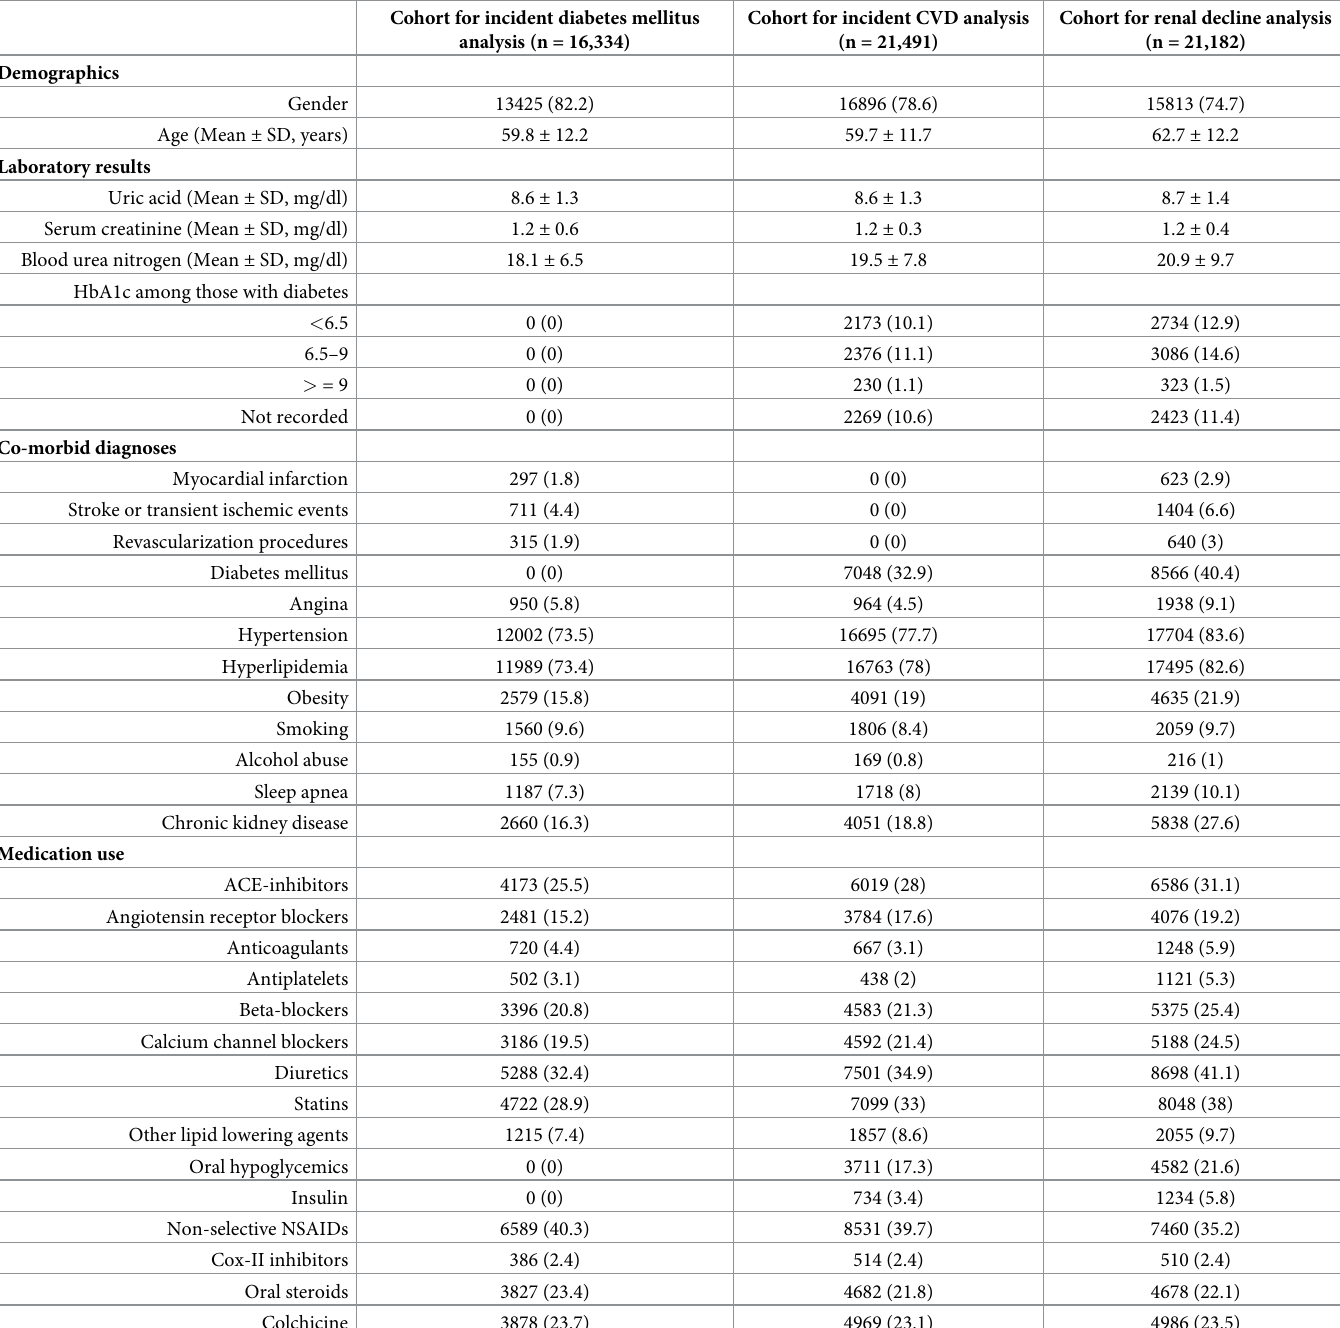
Table 1. Baseline characteristics of gout patients included in the cohort, Clinformatics ™ Datamart